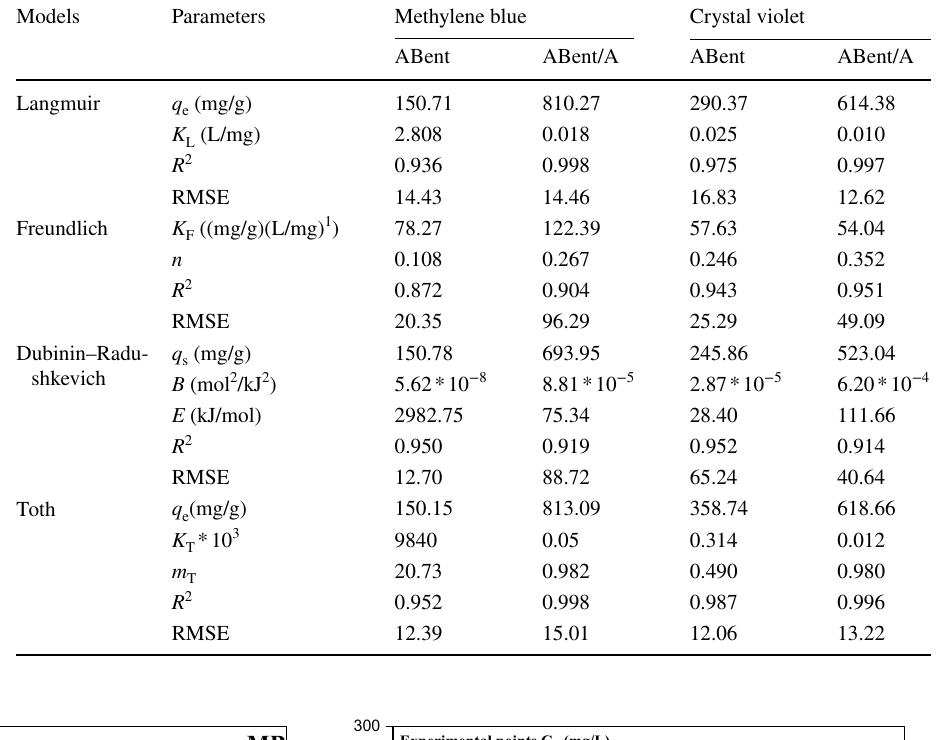
Table 1 Parameters of isotherm models for the adsorption of MB and CV onto adsorbents